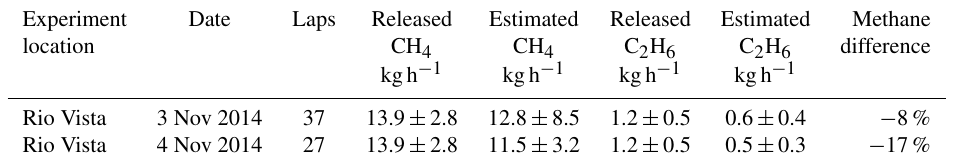
Table 3. Controlled natural gas release.